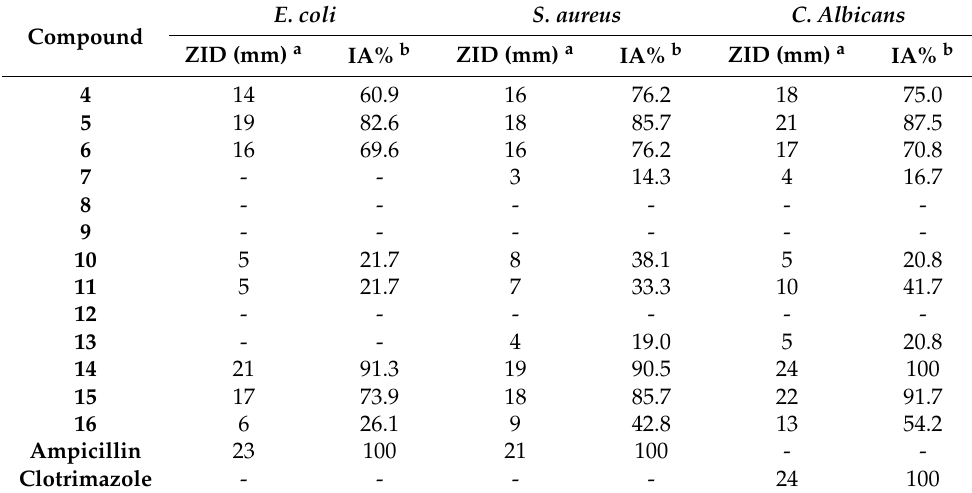
Table 2. The antimicrobial properties of the OSe compounds. Compound